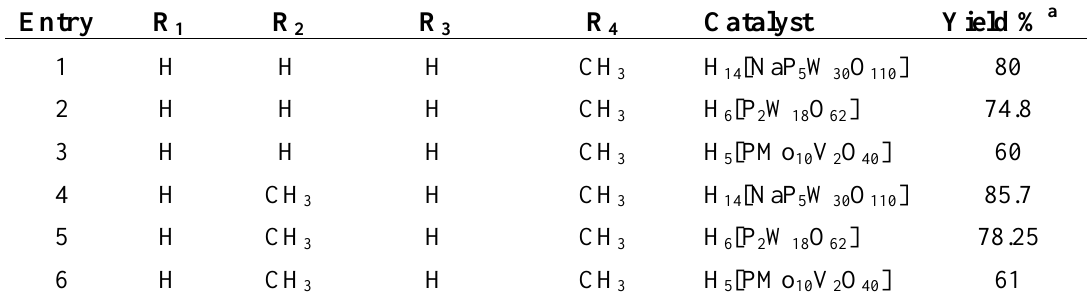
Table 1. Synthesis of 3,1,5-benzoxadiazepines derivatives using various heteropolyacids under refluxing